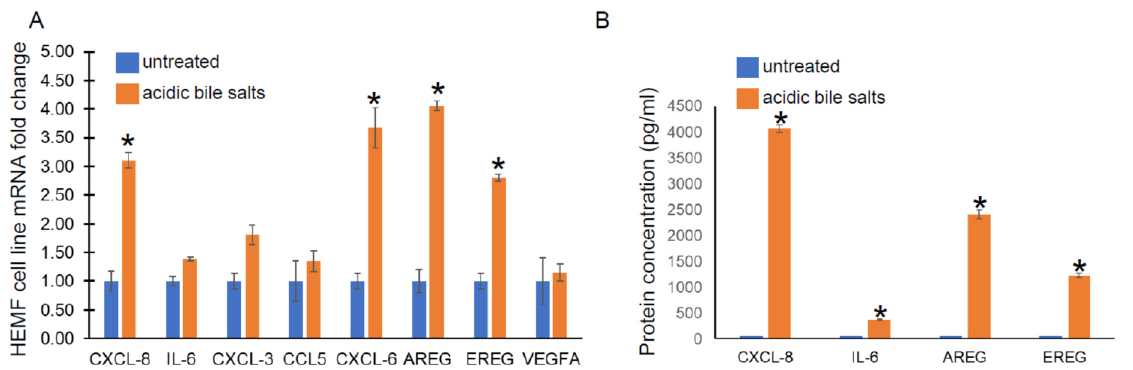
Figure 3. HEMF cell line mRNA expression and protein secretion. ( A ) mRNA expression of upreg- ulated genes identified by RNA sequencing was evaluated in a HEMF cell line similarly treated with acidic bile salts and compared to untreated cells (grown in neutral serum-free myofibroblast media (SFMM; pH 7.2). mRNA expression of the following differentially expressed genes were evaluated: CXCL8, IL-6, CXCL3, CCL5, CXCL6, AREG, EREG, and VEGFA. Statistically significant differences are shown by * symbol with p value ≤ 0.05. Results shown represent the means ± SEM of three independent experiments conducted with HEMF cell line. ( B ) Proteins of genes identified by RNA sequencing were evaluated in supernatant of untreated and acidic-bile-salt-treated HEMFs. Statisti- cally significant differences are shown by * symbol with p value ≤ 0.05. Results shown represent the means ± SEM of three independent experiments conducted with HEMF cell line.